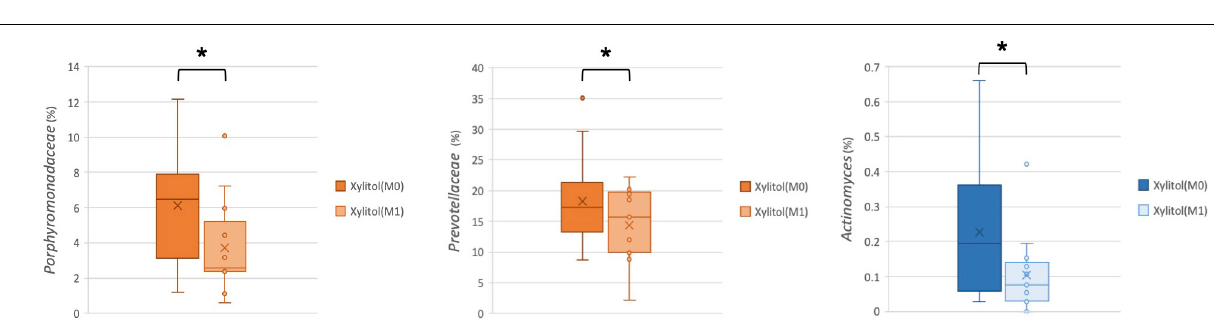
FIGURE 5 | Comparison of the relative abundance of periodontopathic bacteria at the family or genus level in the xylitol gum group at M0 and M1; * p < 0.05, respectively, using Wilcoxon’s